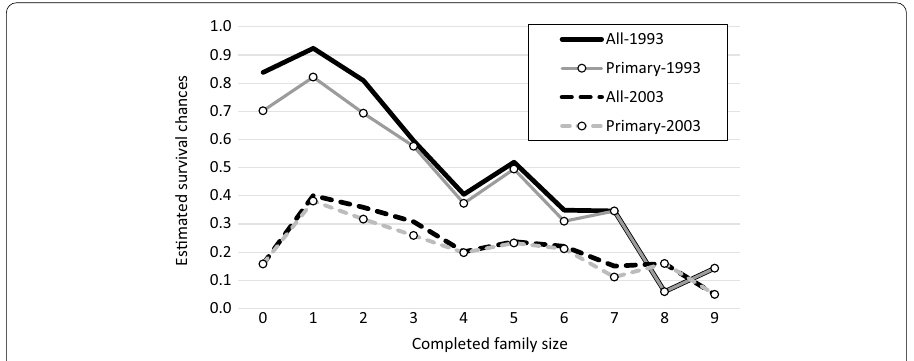
Fig. 4 Survival chances between 1961 and 1993, and between 1961 and 2003, of the cohorts of women born in the years 1912–1916 by CFS and educational level, in Italy (ever-married women). These (ever-married) women were observed in 1961 at 45–49 years (starting point), then in 1993 (at 77–81 years: first check), and then again in 2003 (at 87–91 years: second check). “Primary” means with no or, at most, primary education. We thank Valentina Tocchioni, UNIFI, for her help with Istat’s AVQ data. Source: Istat (1974), Istat-AVQ (individual data of the 1993 and 2003 surveys) and authors’